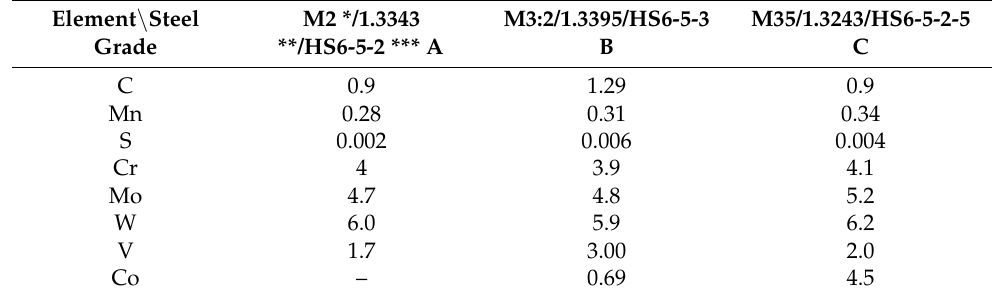
Table 1. Chemical compositions of selected tool steels with different designations * in weight percent. Element \ Steel